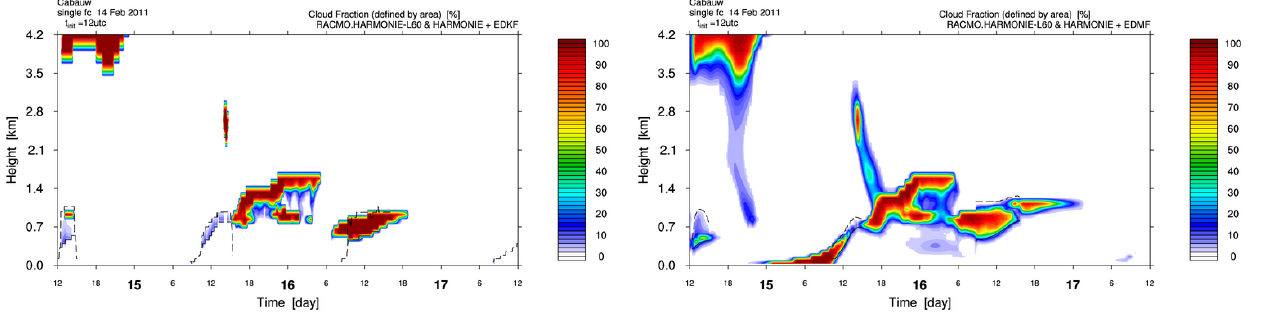
Figure 4. Cloud fraction represented by EDKF (left) and EDMF (right) for 15 February 2011. Note the development of fog during the night with EDMF.